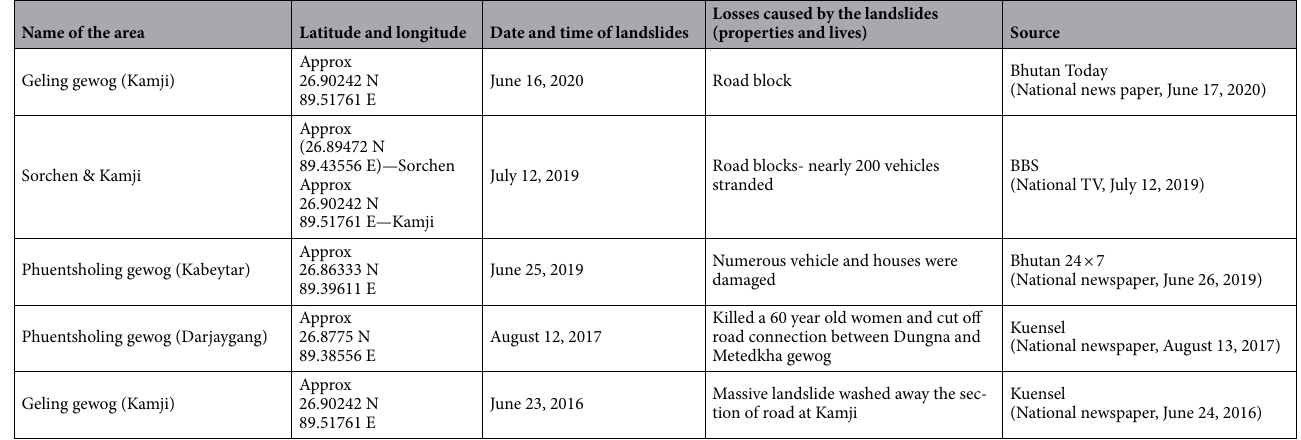
Table 1. Details of some recent major landslides and losses occurred in the study